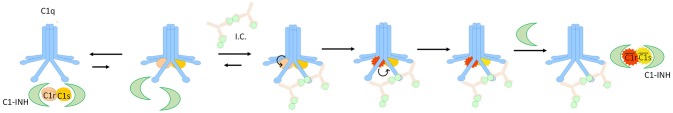
Activation of C1 in presence of C1-INH and immunocomplexes. C1-INH reversibly inhibits in fluid phase the pro-C1r and pro-C1s, when they dissociates from C1-INH they can bind C1q, but this is disfavored. In presence of immunocomplexes (I.C.), the association of C1r2s2 to C1q is favored and stable, so C1q activates C1r which in turn cleaves C1s. Afterwards, the activated C1r2s2 (indicated as C1r¯ and C1s¯) is then displaced from C1q and irreversibily inhibited by C1-INH.